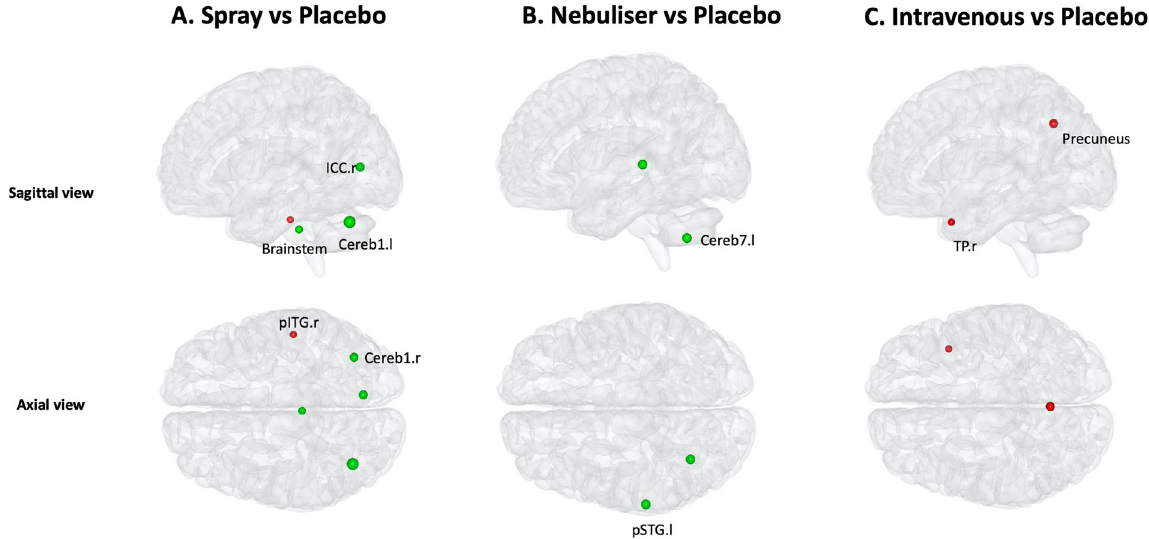
Fig. 4 Effects of exogenous oxytocin on nodal degree. For each node, we compared node degree between the four treatment conditions using repeated measures one-way analysis of variance. Since we performed tests for multiple nodes, we controlled false positives using FDR correction for the number of nodes examined. When a signi fi cant effect was found, we explored this effect further using paired t -tests for each pair of treatment groups, correcting for multiple testing using FDR. In this fi gure, we provide an overview of the pattern of changes in node degree for each method of administration by showing the results of the post-hoc tests focusing on the comparisons between each active treatment arm and placebo (for direct comparisons between active treatment arms, please refer to Table S3). The green and red colours depict increases and decreases in node degree, respectively. The size of each nodal sphere is proportional to the T-statistic of each comparison. The name of each node appears once, in the axial or sagittal view, to avoid cluttering the fi gure. R right, l left, a anterior, p posterior, ICC intracalcarine cortex, Cereb Cerebellum, ITG inferior temporal gyrus, TP temporal pole, STG superior temporal gyrus.